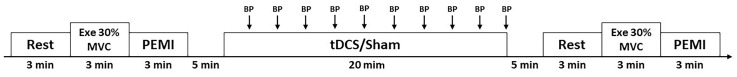
Overall view of the experimental protocol during resting condition (Rest), during intermittent handgrip exercise (Exe) and post-exercise muscle ischemia (PEMI) in all conditions. BP, blood pressure measurement; MVC, maximal voluntary contraction.